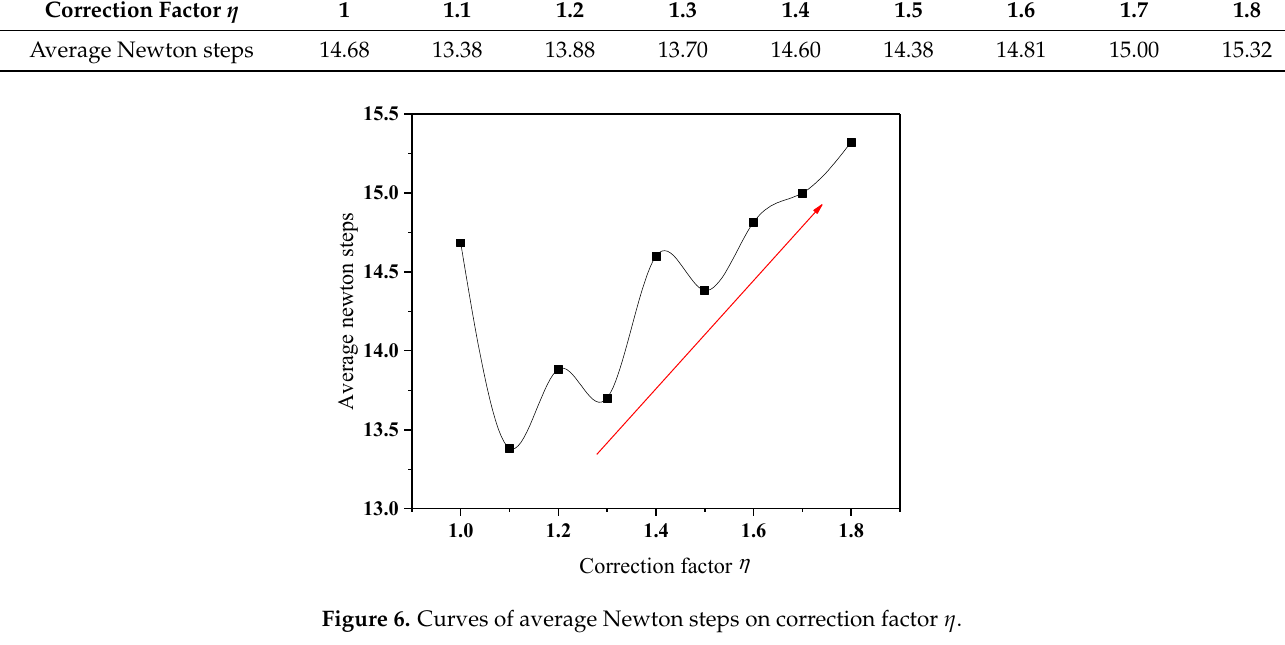
Figure 6. Curves of average Newton steps on correction factor